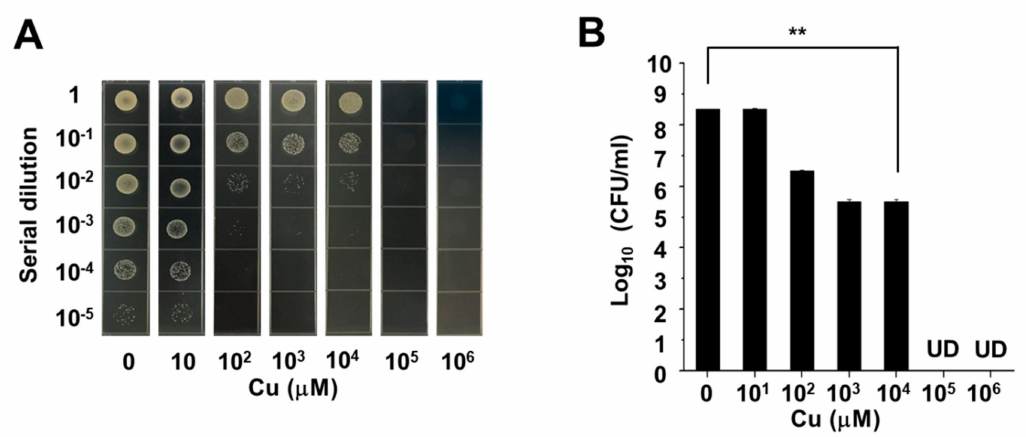
Figure 7. MBC assay of copper. Six di ff erent concentrations of copper chloride solution (10 µ M, 10 2 µ M, 10 3 µ M, 10 4 µ M, 10 5 µ M, 10 6 µ M). The mixtures of the bacterial suspension and the copper chloride solution were enumerated by plating serial dilutions ( A ). The number (log 10 CFU / mL) of USA300 were quantified ( B ). ** p < 0.01 (two-tailed t-tests). Data are the mean ± SD of three separate